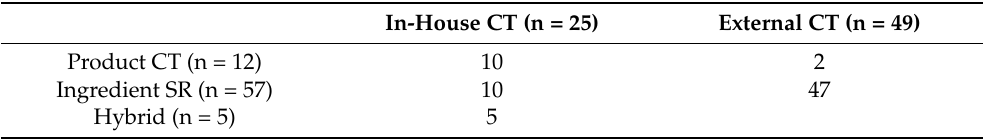
Table 5. Notification routes for foods with function claims (FFC) and the number of products by clinical trial implementation body (n =